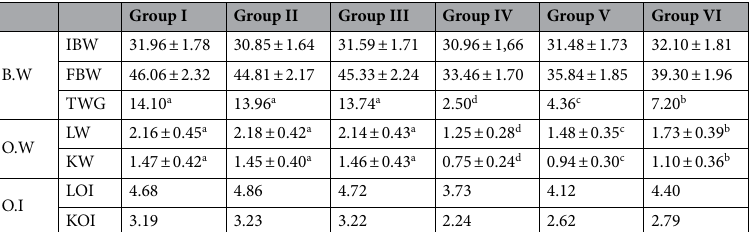
Table 2. Effect of AFM 2 and quercetin on body, liver, kidney weights and organ index. Group I: control, Group II: 25 mg/kg b.w quercetin, Group III: 50 mg/kg b.w quercetin, Group IV: 16 mg/kg b.w AFM 2 , Group V: 16 mg/kg b.w AFM 2 + 25 mg/kg b.w quercetin, Group VI: 16 mg/kg b.w AFM 2 + 50 mg/kg b.w quercetin. BW Body weight, OW Organ weight, OI Organ index, IBW Initial body weight, FBW Final body weight,